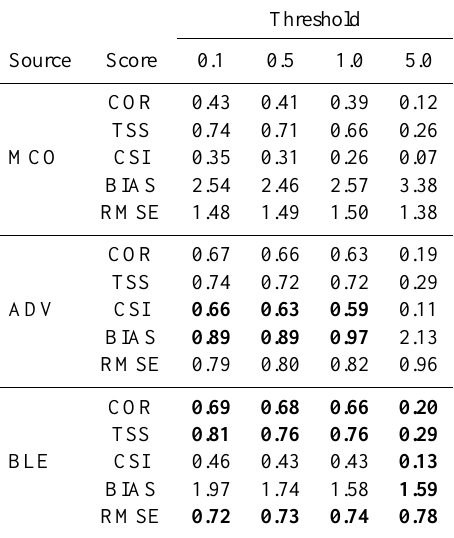
Table 5. Several Verification indexes for different thresholds for the first hour blending forecast (BLE), Model correction (MCO) and advection of reflectivity field (ADV) plotted in Fig. 5. Best results are marked in